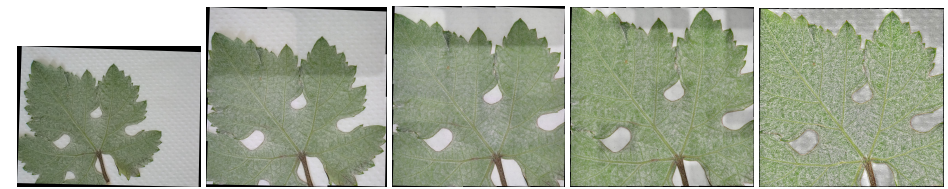
Figure 12. Fiona.